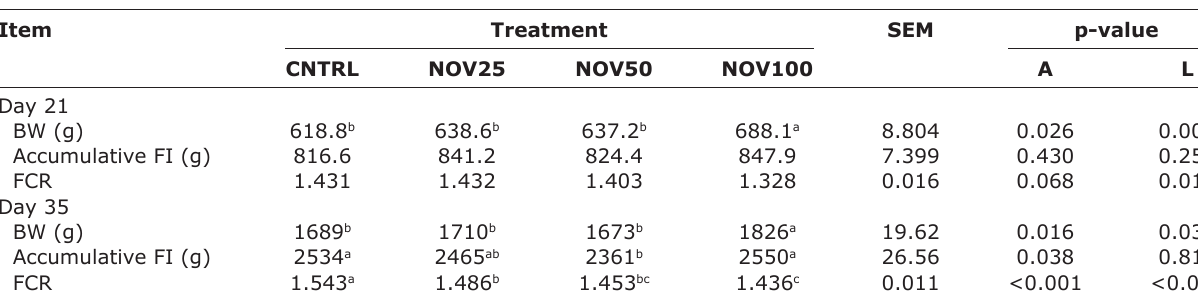
Table-2: Performances of broilers. Item